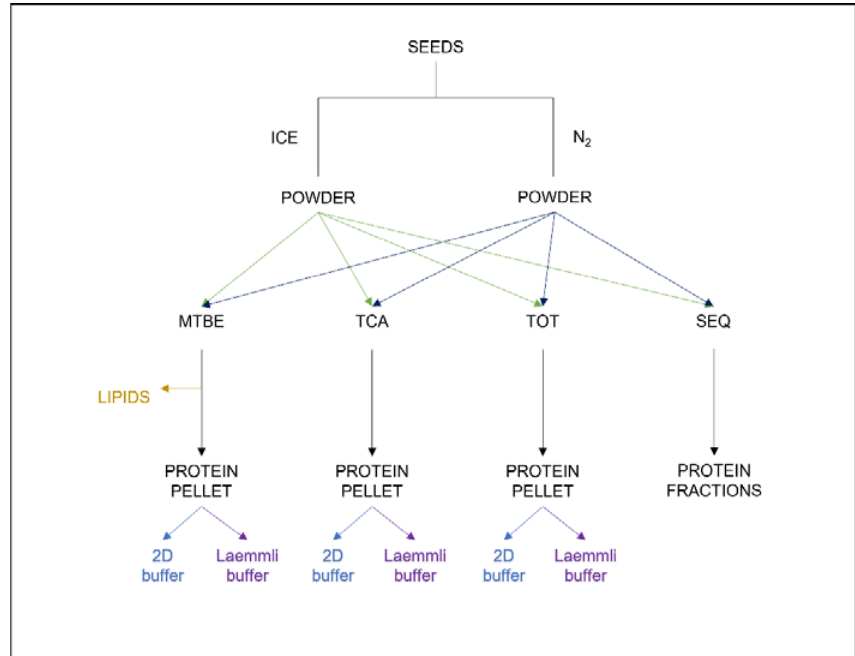
Figure 1. Workflow of experiments. ICE: powder produced by holding the mortar on ice (4 °C), N 2 : powder produced in the presence of liquid nitrogen. MTBE: total protein extraction after delipidation with MTBE: MeOH; TCA: total protein extraction after precipitation in TCA/acetone; TOT: total protein extraction after delipidation with hexane; SEQ: sequential protein extraction after delipidation with hexane.